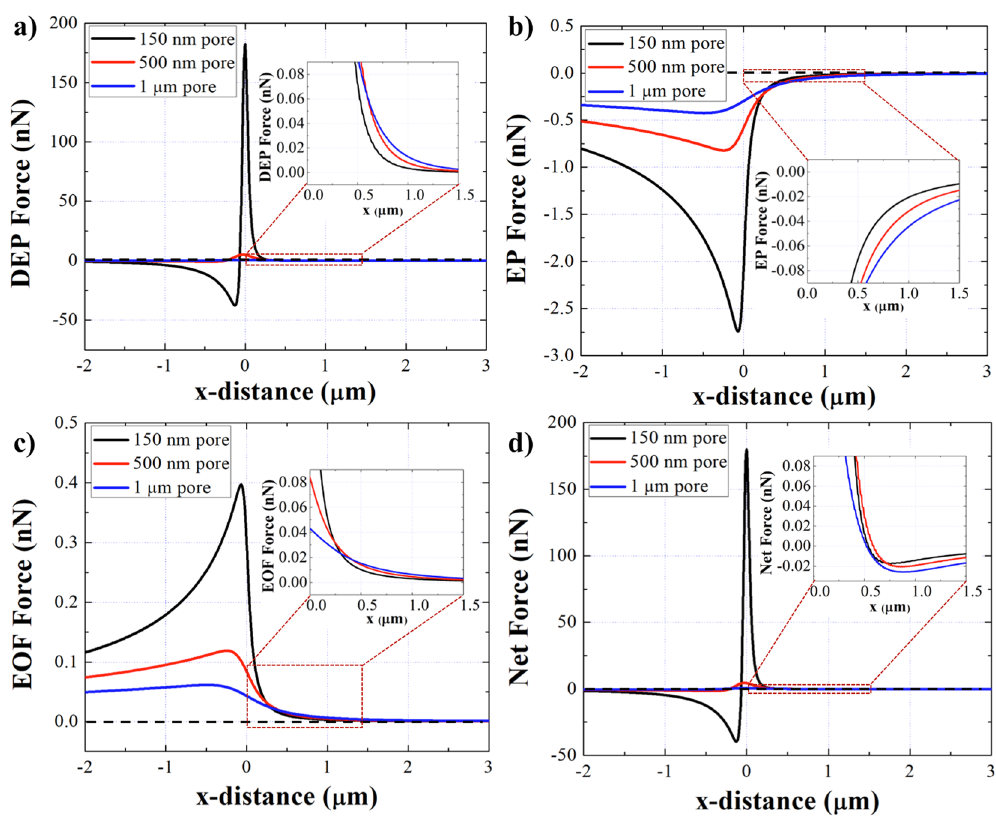
Figure 5. The distribution of EK forces applied on the 510 nm COOH-PS beads in 10 mM KCl with different pore diameters under positve 10 V/cm bias at the base. ( a ) DEP, ( b ) EP, ( c ) EOF and ( d ) the net EK forces along the length of the pipette. The zoom in inserted figures show the distribution of forces in fornt of the pipette’s tip at the trapping zone where the forces are